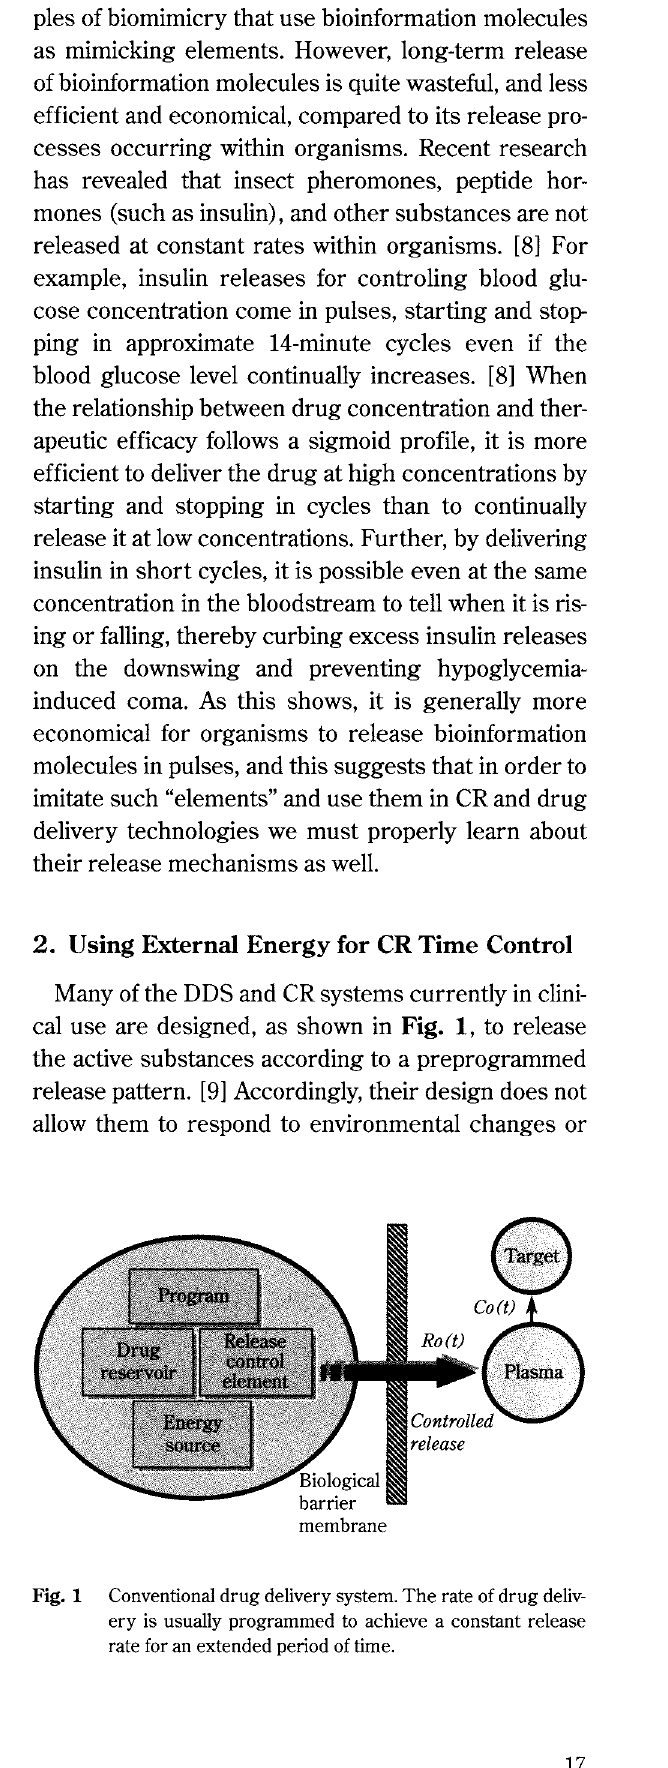
Conventional drug delivery system. The rate of drug deliv ery is usually programmed to achieve a constant release rate for an extended period of